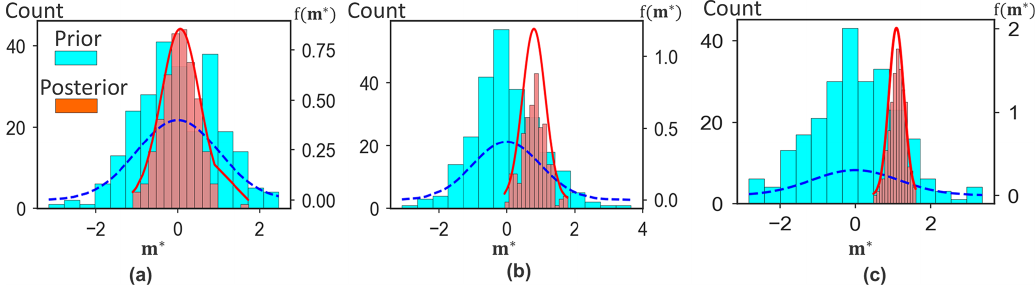
Figure 16. Reduction in uncertainty of the first model canonical component: (a) porosity, (b) log-perm, and (c) Sw.